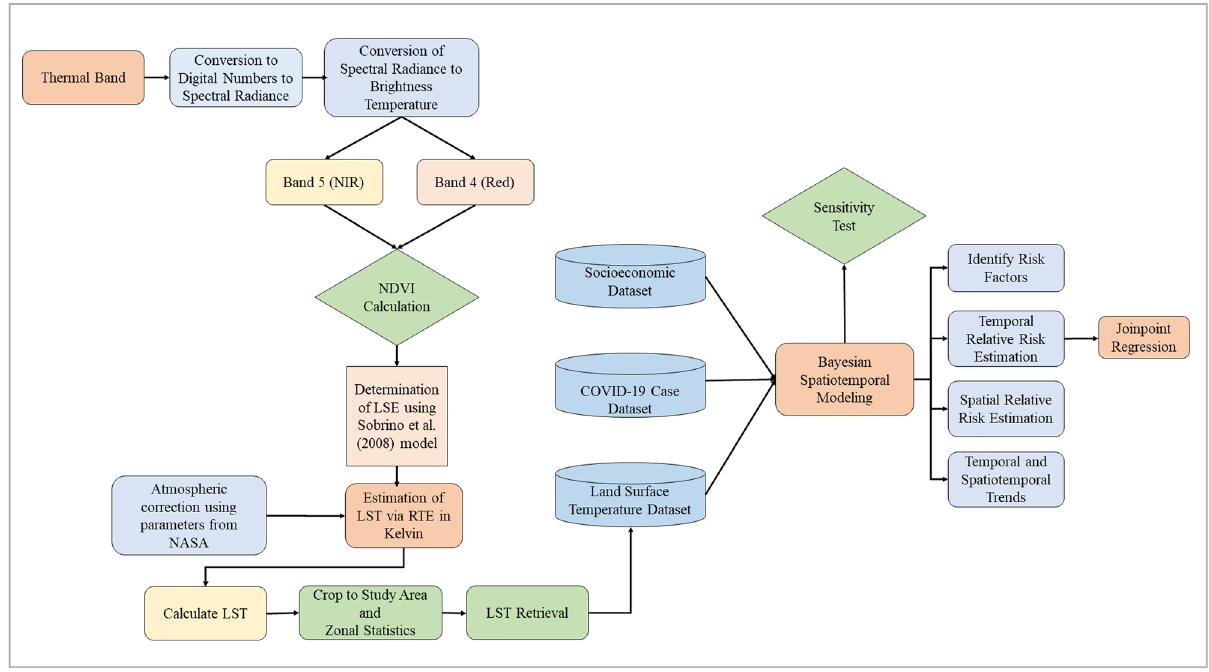
Figure 2. Flow diagram of the methodological